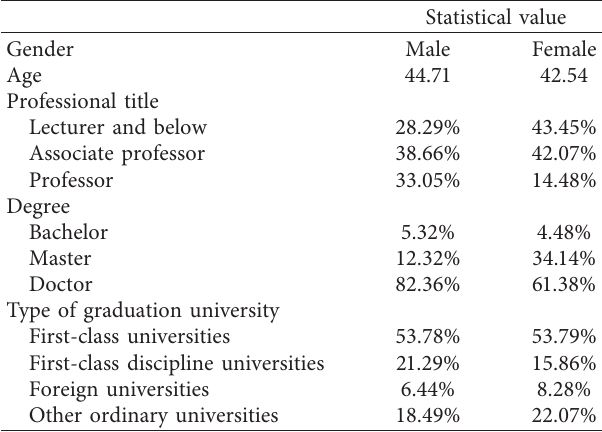
Figure 3: Average of total research work of male and female teachers of each college. Table 1: Sample composition.